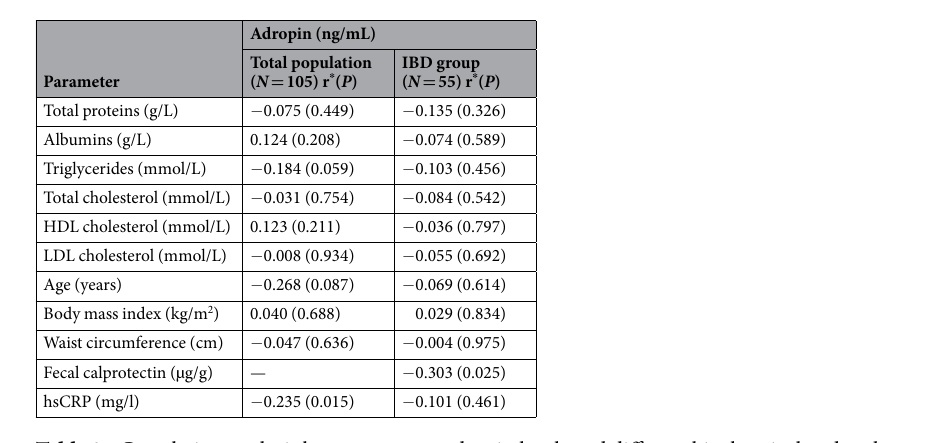
Table 3. Correlation analysis between serum adropin levels and different biochemical and anthropometric parameters. Abbreviations: hsCRP- high sensitivity C-reactive protein; IBD- Inflammatory Bowel Disease.